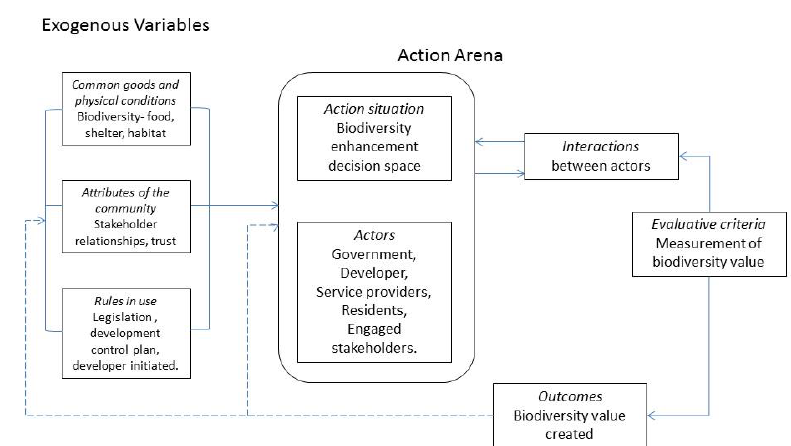
Figure 1. Application of the IAD (Institutional Analysis and Development) framework and establishes the nature of the relationships between institutions affecting the management of biodiversity in an urban setting. Adapted from Ostrom [32].